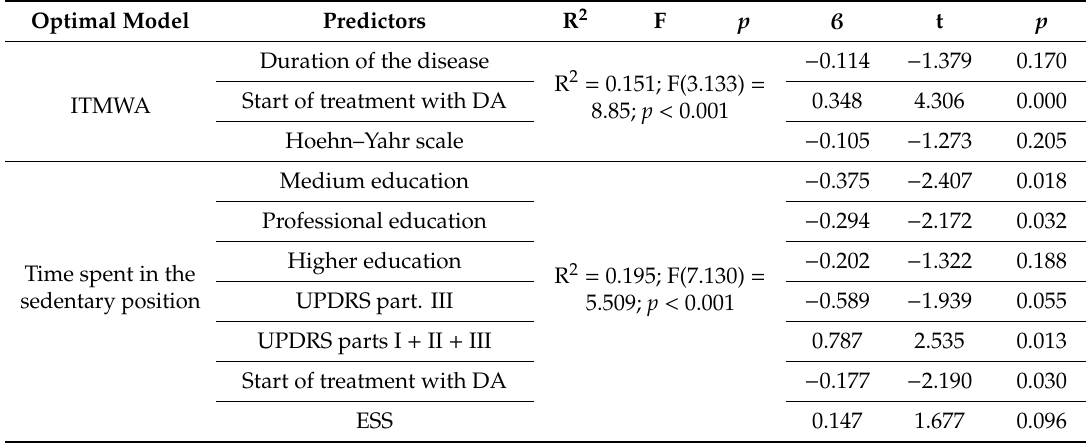
Table 5. Analysis of backward regression, which determines % of the variability of ITMWA and time spent in the sedentary position in a day in the group of patients with Parkinson’s disease (solely optimum models with the highest R 2 are presented).